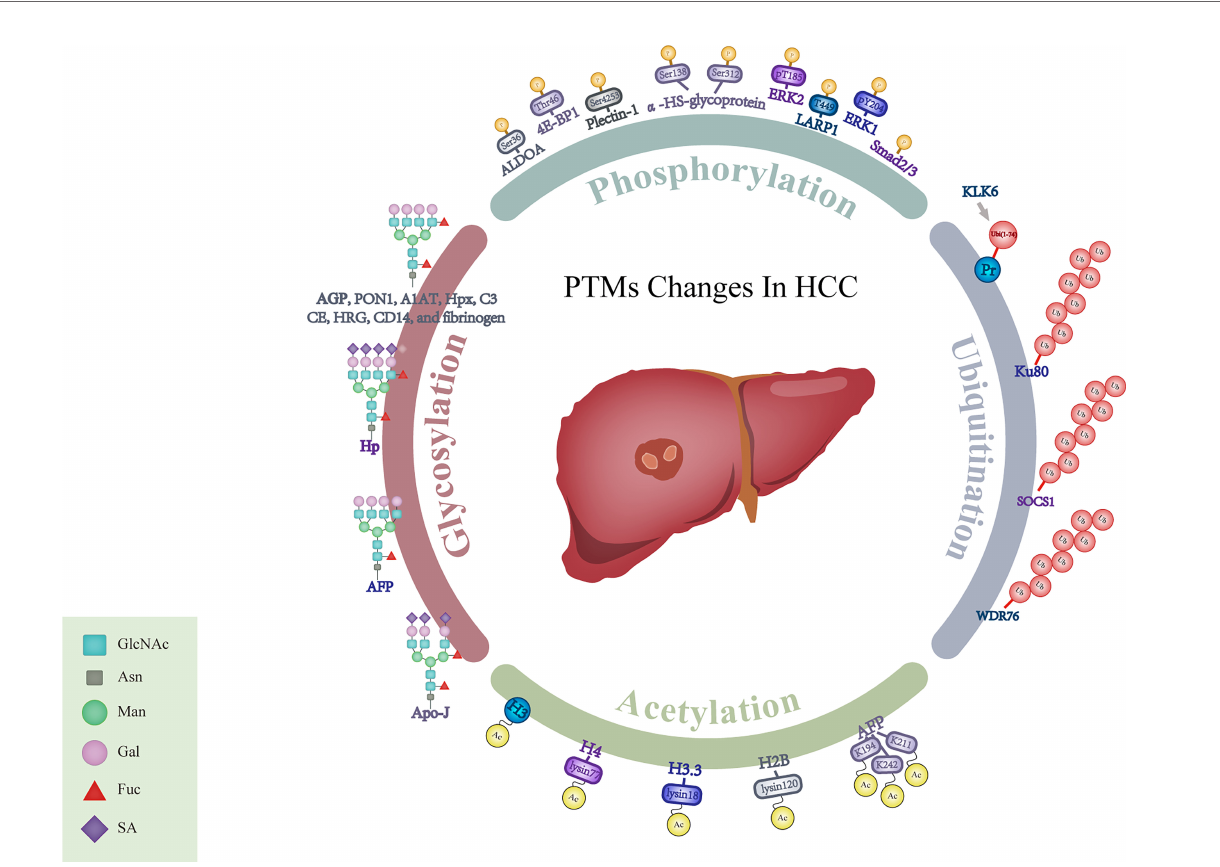
FIGURE 1 | Schematic representation for alterations of PTMs in HCC. GlcNAc, N-acetylglucosamine; Asn, Asparagine; Man, Mannose; Gal, Galactose; Fuc, Fucose; SA, Sialic Acid; AGP, a 1-acid glycoprotein; PON1, Paraoxonase 1; A1AT, a -1- antitrypsin; Hpx, Hemopexin; C3, Complement C3; CE, Ceruloplasmin; HRG, Histidine-rich glycoprotein; Hp, Haptoglobin; AFP, a -fetoprotein; Apo-J, Apolipoprotein J; ALDOA, Aldolase A; 4E-BP1, 4E-binding protein 1; ERK1, Extracellular regulated protein kinases 1; ERK2, Extracellular regulated protein kinases 2; LARP1, La-related protein 1; Smad2/3, Mothers against decapentaplegic homolog 2/3; a -HS-glycoprotein, a - Heremans-Schmid-glycoprotein; KLK6, Kallikrein-related peptidase 6; Pr, Protein; SOCS1, Suppressor of cytokine signaling 1; WDR76, WD40-repeat protein 76; H2B, Histone 2B; H3.3, Histone 3.3; H4, Histone 4; H3, Histone